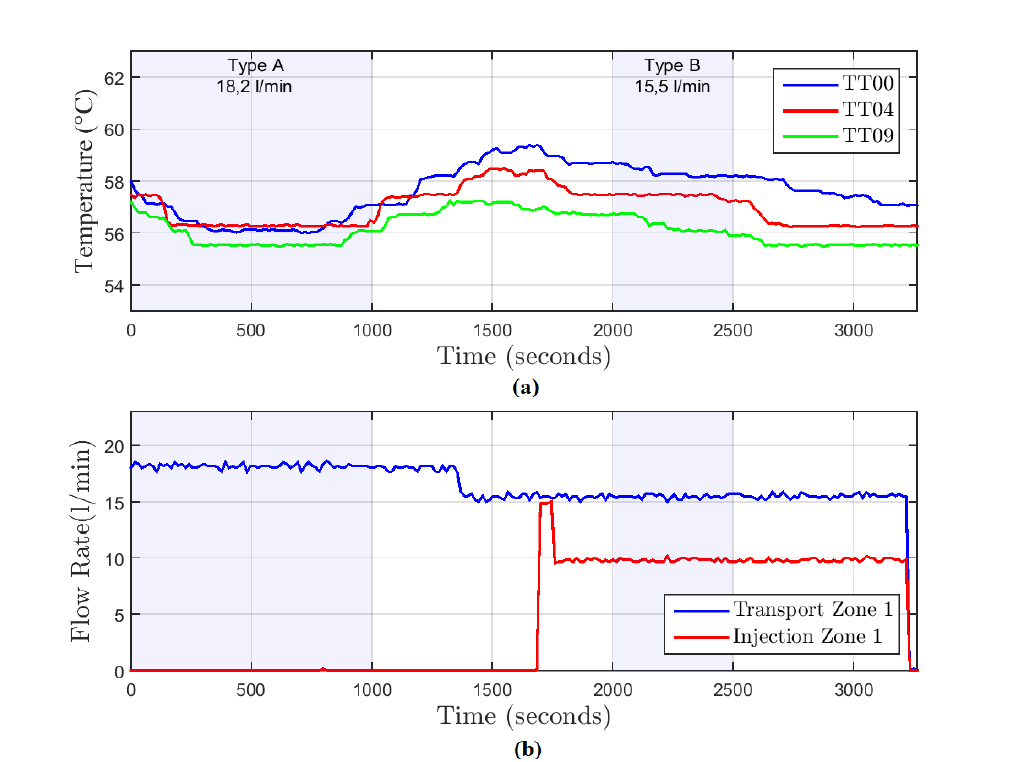
Figure 9. Graphs of temperature and flow rate with time. ( a ) Graph of temperature with time along the transport zone 1. ( b ) Graph of flow rate with time in transport zone 1 and injection zone